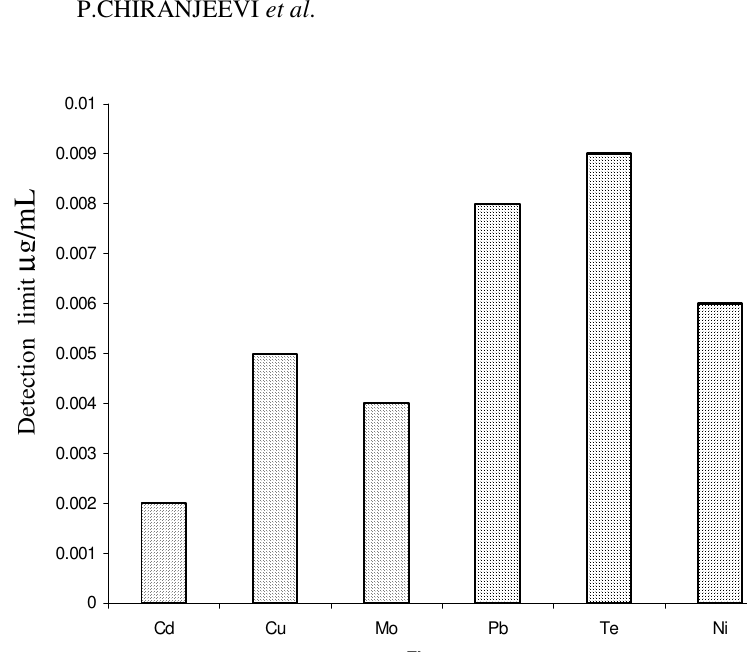
Figure 4. Detection limit for determination Trace Elements by AAS after preconcentration on polyurethane foam loaded with coniine